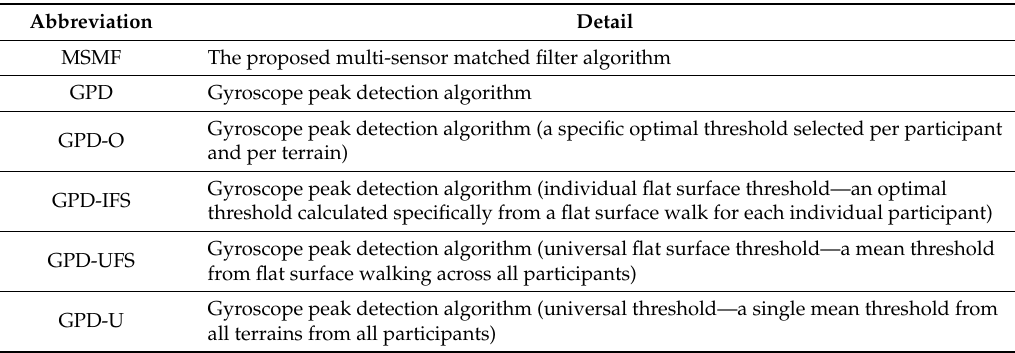
Table 2. The algorithm variations tested for each